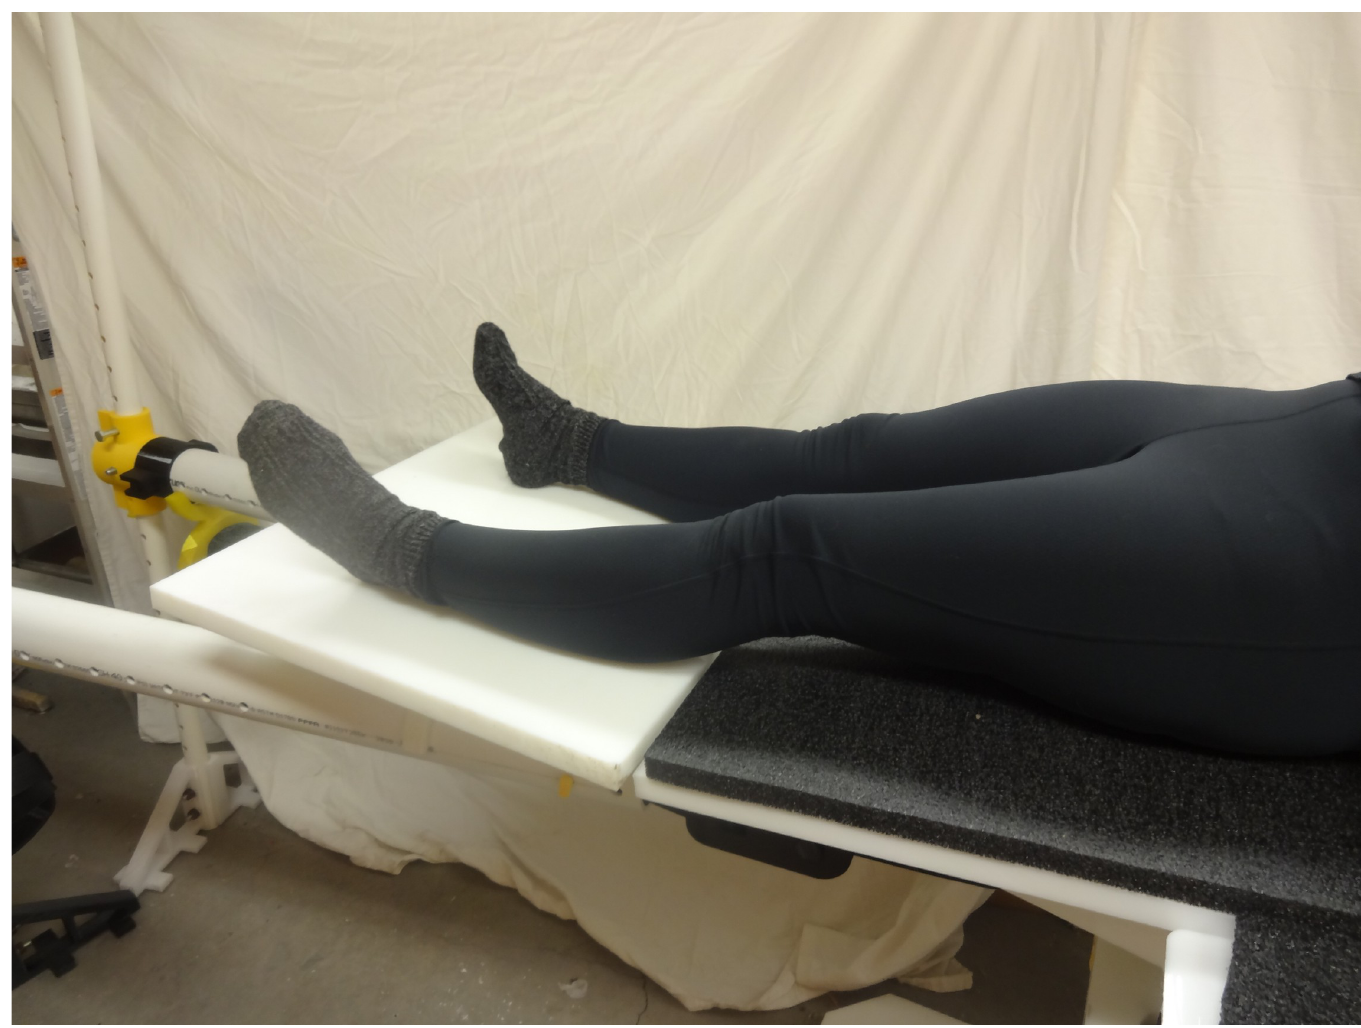
Fig 35. Table with simulated patient when table extension is